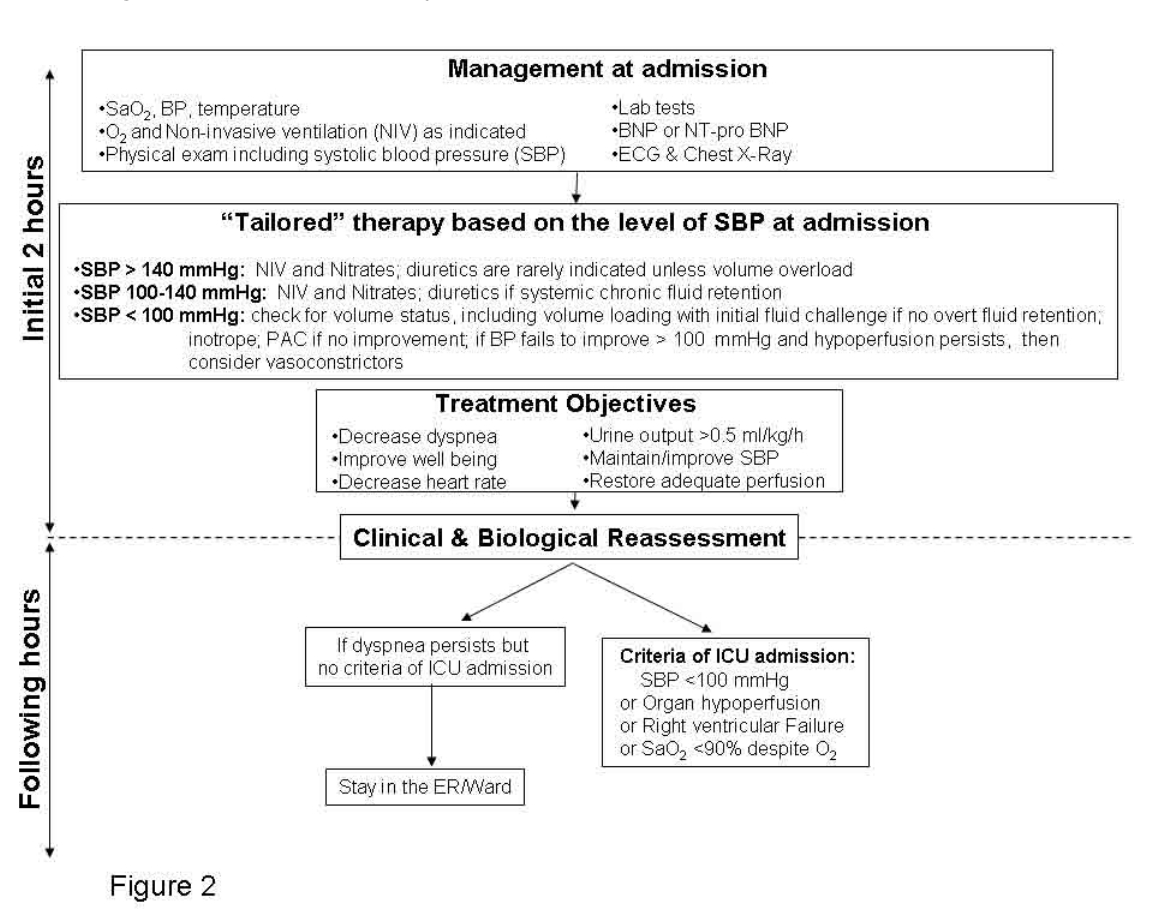
Figure 2 Initial management of acute heart failure syndromes [modified from